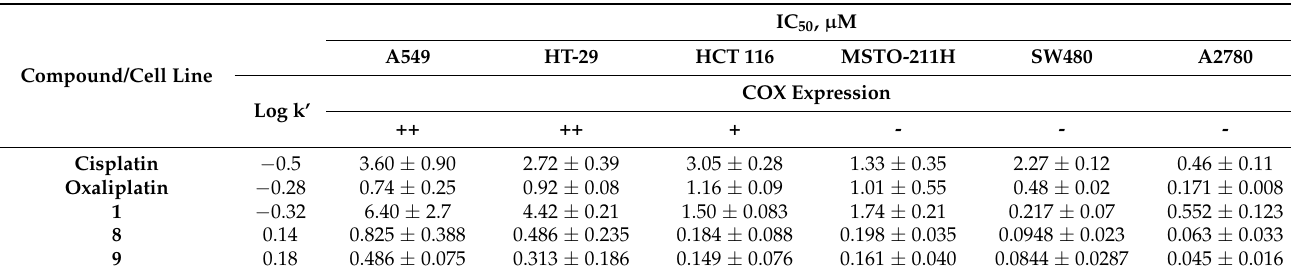
Table 8. Antiproliferative activity of cisplatin-based prodrugs 1 , 8 and 9 on A549 (lung carcinoma), HT-29 (colon cancer), HCT 116 (colon adenocarcinoma), SW480 (colorectal cancer), A2780 (ovarian cancer), and MSTO-21 (malignant pleural mesothelioma) cell lines.